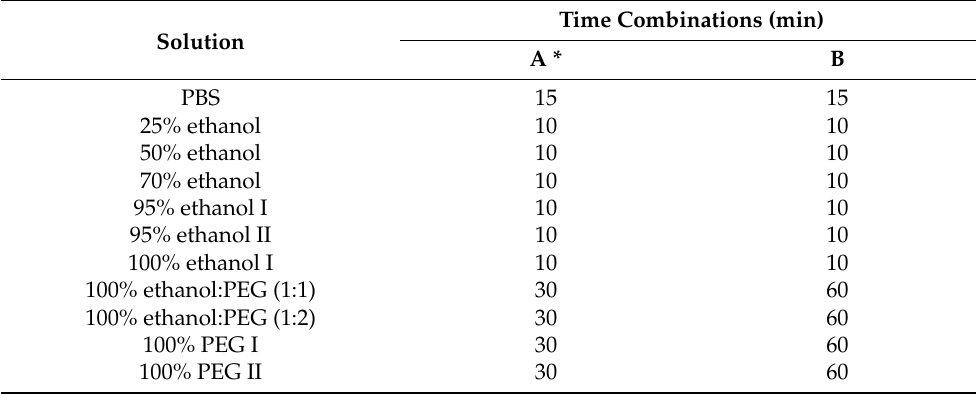
Table 3. Summary of method 1 in PEG processing.